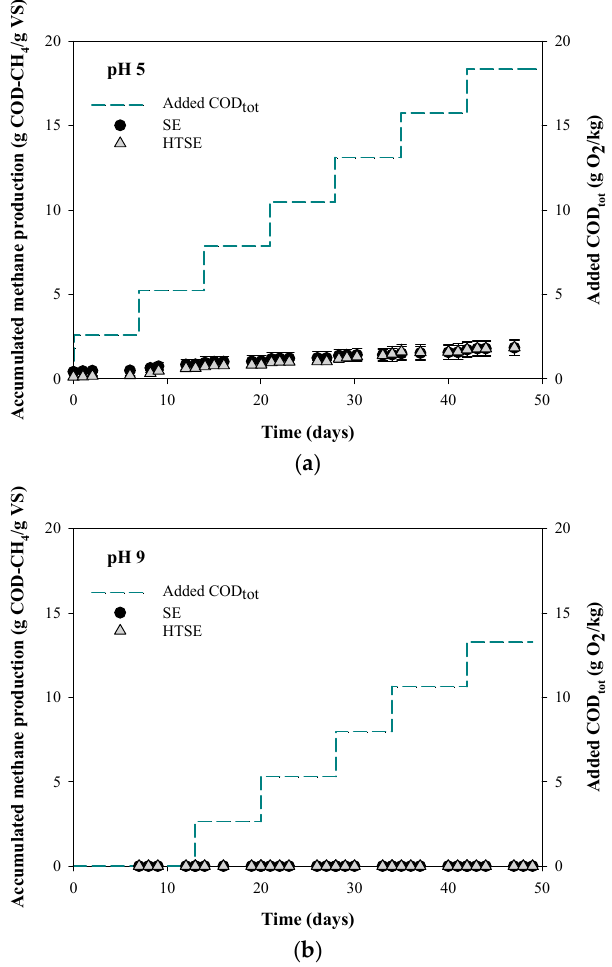
Figure 2. Accumulated methane production from SE and HTSE ( a ) at a pH of 5 and ( b ) at a pH of 9 with respect to feed.